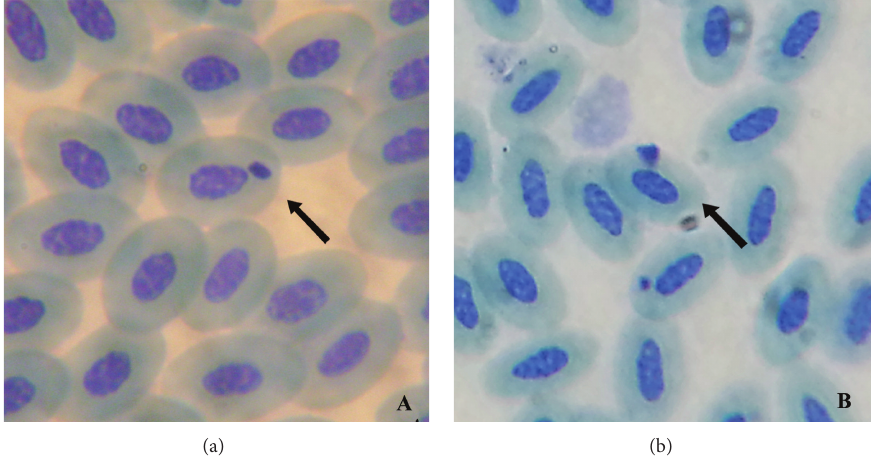
Figure 3: (a) Trophozoite of P. relictum. (b) Trophozoite of P. lutzi